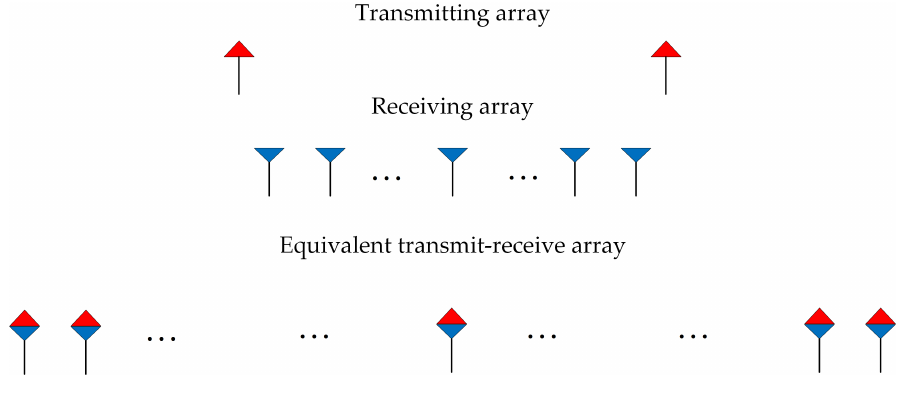
Figure 3. MIMO radar array structure of simulation experiment.